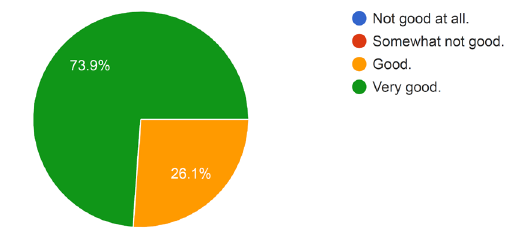
Fig. 6 – Quality of the pedagogical approach followed in the